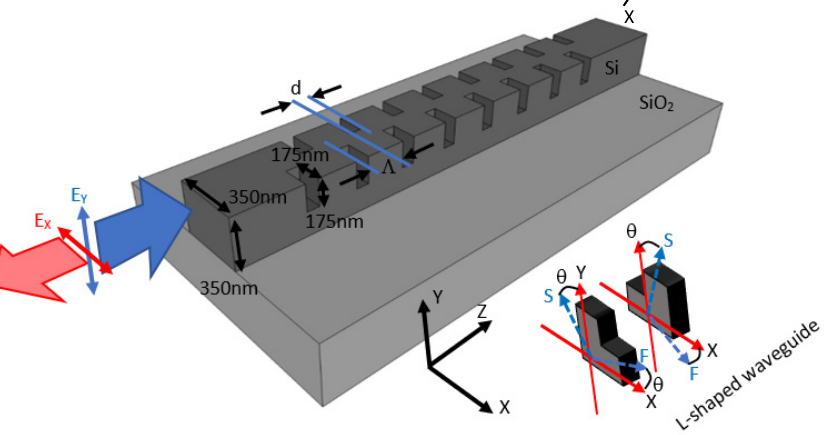
Figure 1. Reflective polarization rotator in the silicon waveguide with corrugation rectangular air holes. The cross-section of the L-shaped waveguide formed by the etched rectangular air hole is presented. The S -axis and F -axis are the slow and fast axes, respectively.